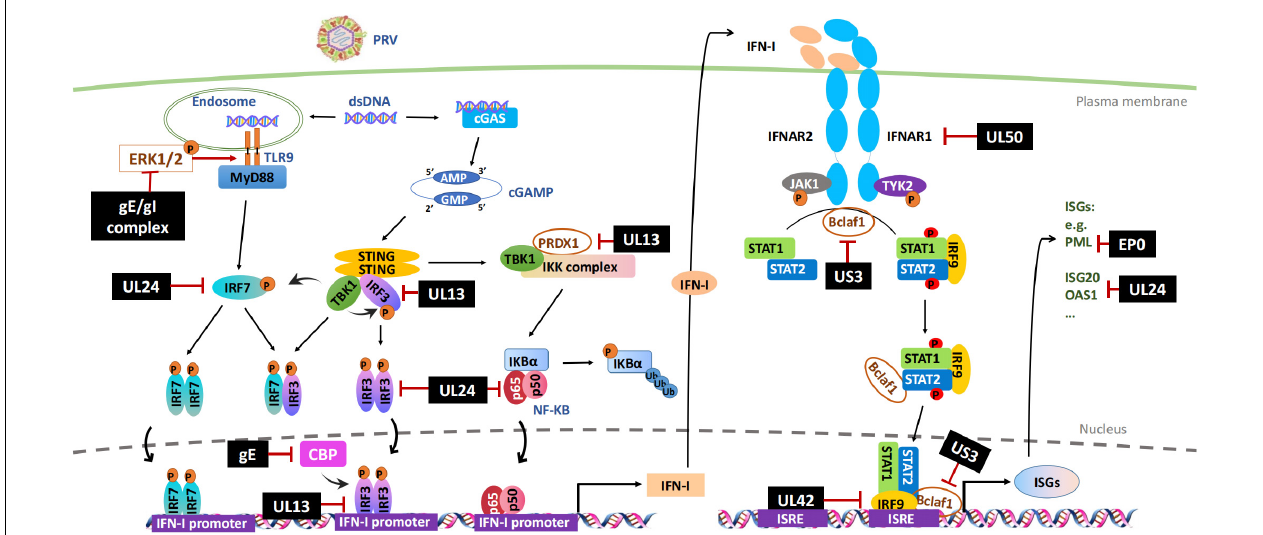
FIGURE 1 | Evasion of IFN-I-mediated innate immunity by PRV. Cytosolic DNA sensors, such as cGAS and TLR9, recognize double-stranded DNA in the cytosol and trigger IFN-I production through IRFs or NF- κ B signal pathways. After secretion, IFN-I binds to its cognate receptor (IFNAR1 and IFNAR2) on the cell surface and induces the transcription of antiviral factors ISGs through JAK-STAT signal pathway. PRV encoded multiple proteins can target various steps involved in this process, including hijacking DNA-sensor-mediated viral recognition and subsequent signaling, disrupting JAK-STAT signaling or inhibiting specific ISGs. The black boxes indicate the PRV proteins that are confirmed to hijack IFN-I signal pathway. P, phosphrylation; Ub,